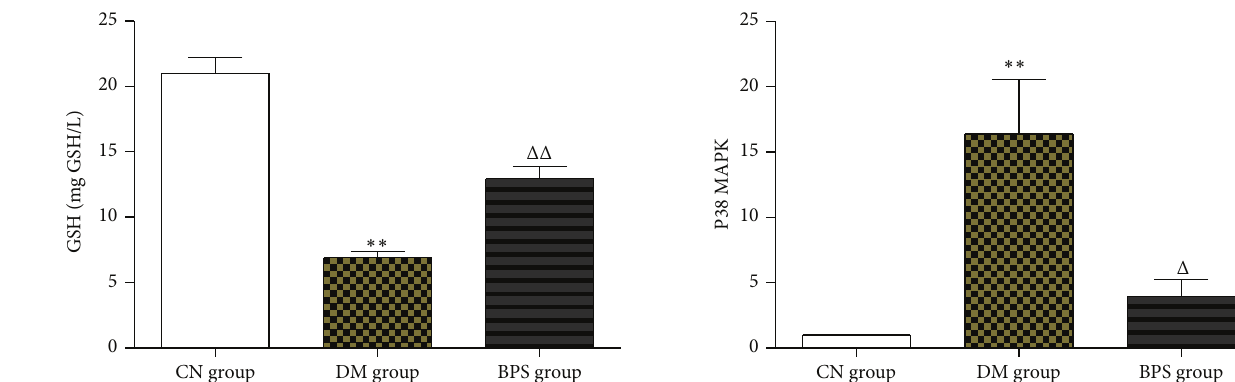
Figure 6: RT-PCR results of p38 MAPK gen. Compared with the CN group, the expression of p38 MAPK mRNA in the myocardial tissues of rats significantly increased in the DM group ( 𝑃 < 0.01 ) and also increased in the BPS group ( 𝑃 > 0.05 ). Compared with the DM group, the expression of p38 MAPK mRNA in rats in the BPS group significantly decreased ( 𝑃 < 0.01 ) and was similar to the level in the CN group ( 𝑃 > 0.05